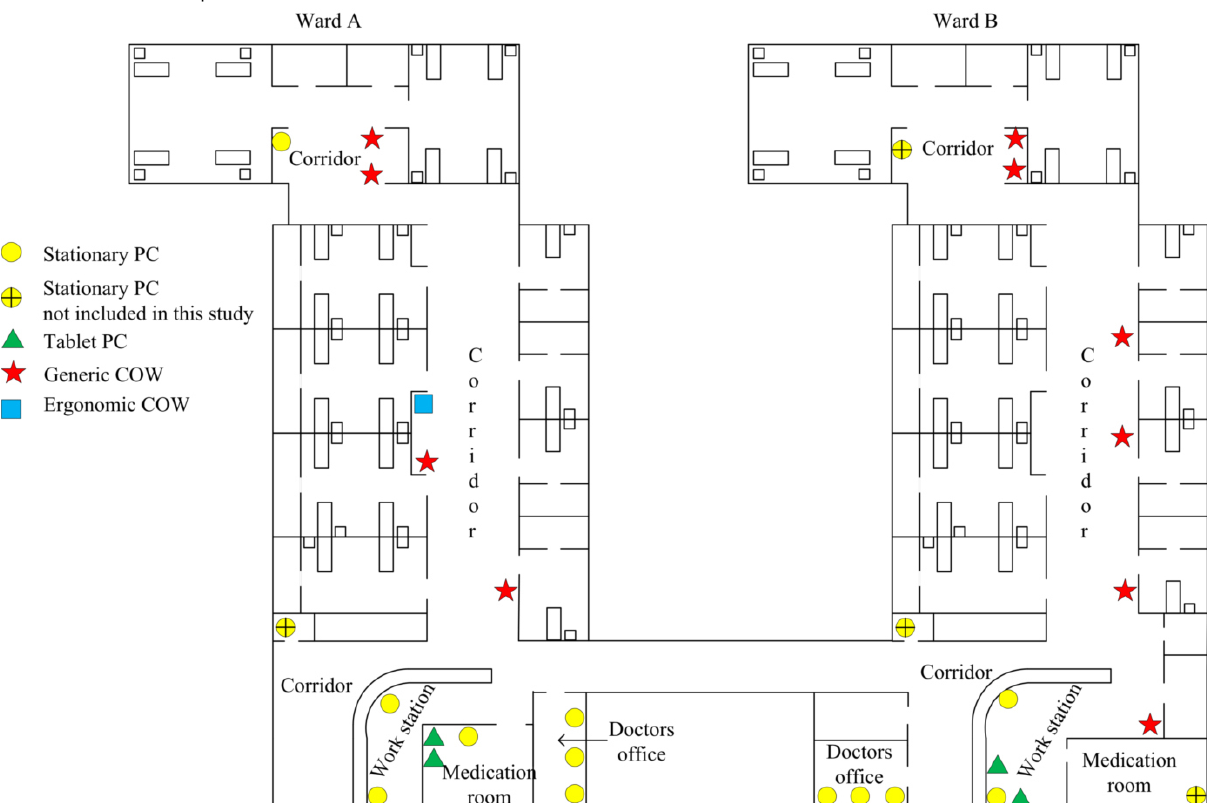
Figure 1. Overview of the placement of devices in ward A and ward